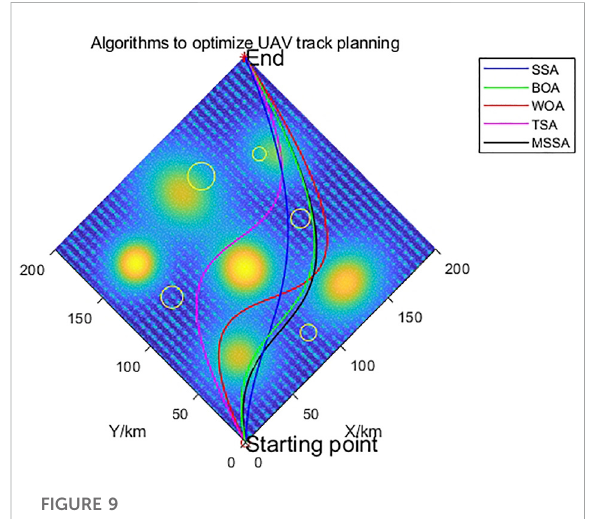
FIGURE 9 Comparison of 2D track planning in environment 1.